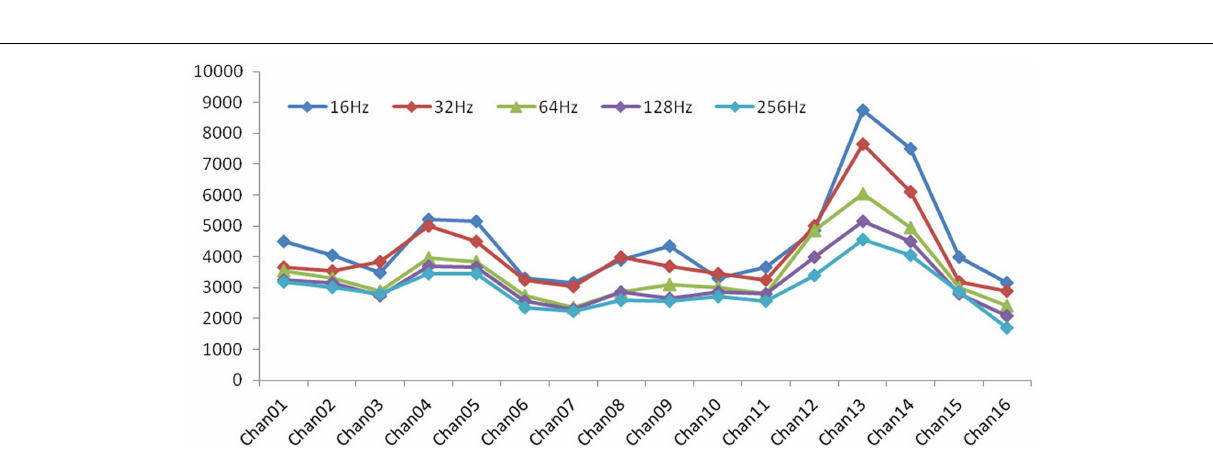
FIGURE 5 | Location of the grid on the cortex (A); frontal X-ray showing the position of the whole device (B) and the lateral view (C) .